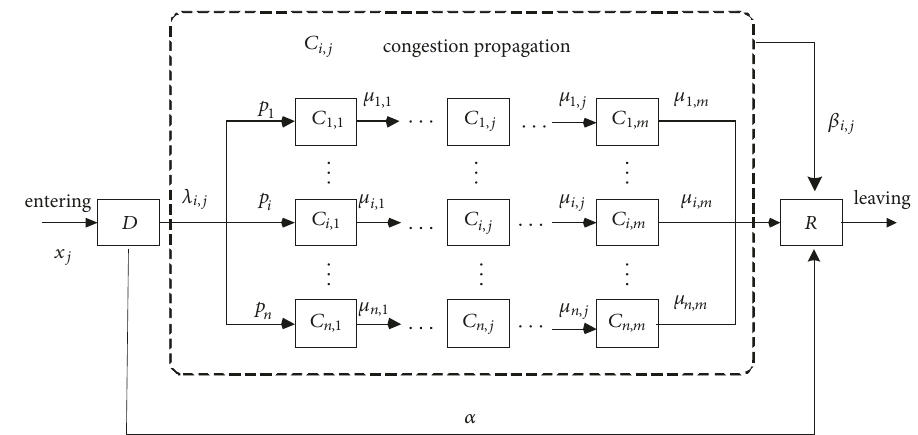
Figure 6: Multievent and multistage model on homogeneous network.